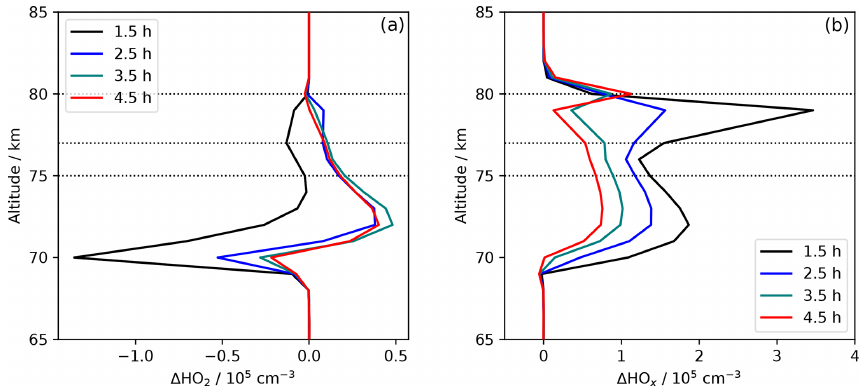
Figure 11. Concentration differences between sprite and no-sprite simulation as a function of altitude for different times after the sprite discharge for RUN1. (a) (cid:49) HO 2 ; (b) (cid:49) HO x . The dashed lines marks the SMILES measurement tangent height altitudes of 75, 77, and 80km.